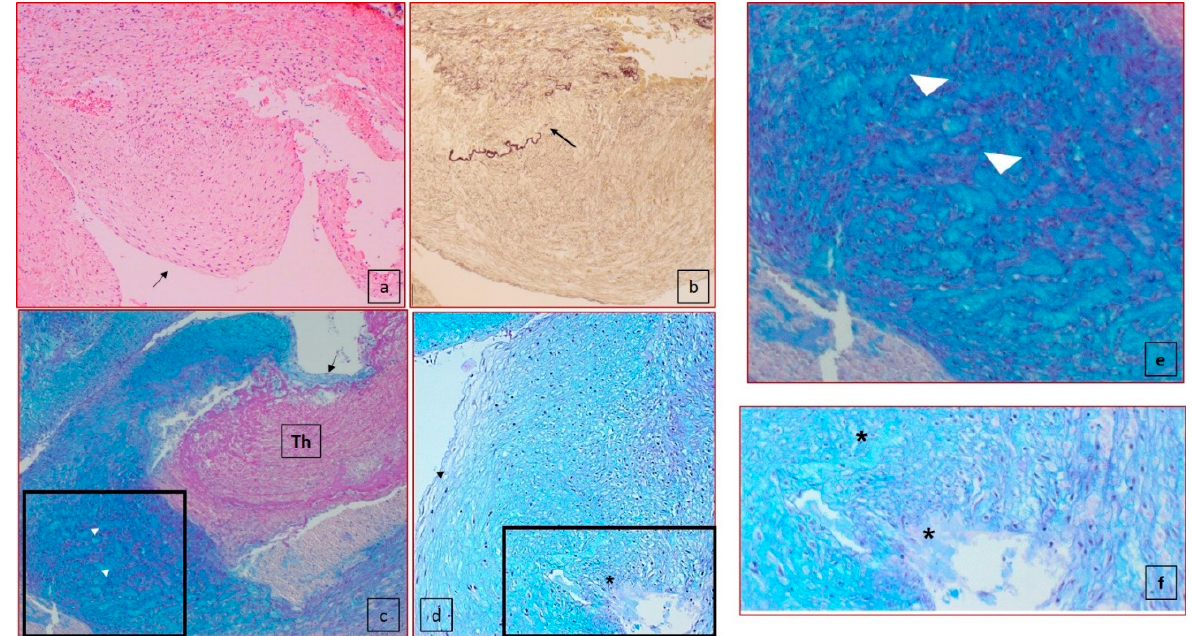
Figure 4. Histology of the ductus arteriosus. ( a ) Subendothelial intimal cushion (case 5) (50× magnification, black arrow); ( b ) elastic fiber–van Gieson (50× magnification) showed the interruption of the internal elastic lamina (black arrow); ( c ) presence of lacunar spaces (white arrow head) in the media closed to dissection (black arrow) (100× magnification) with thrombus formation (Th); ( d ) lacunar spaces, cystic medial necrosis (*) in the media, under the intimal proliferation (black arrow head) (100×). ( e ) High-power view of the insert highlighted in ( c ). ( f ) High-power view of the insert highlighted in ( d ).